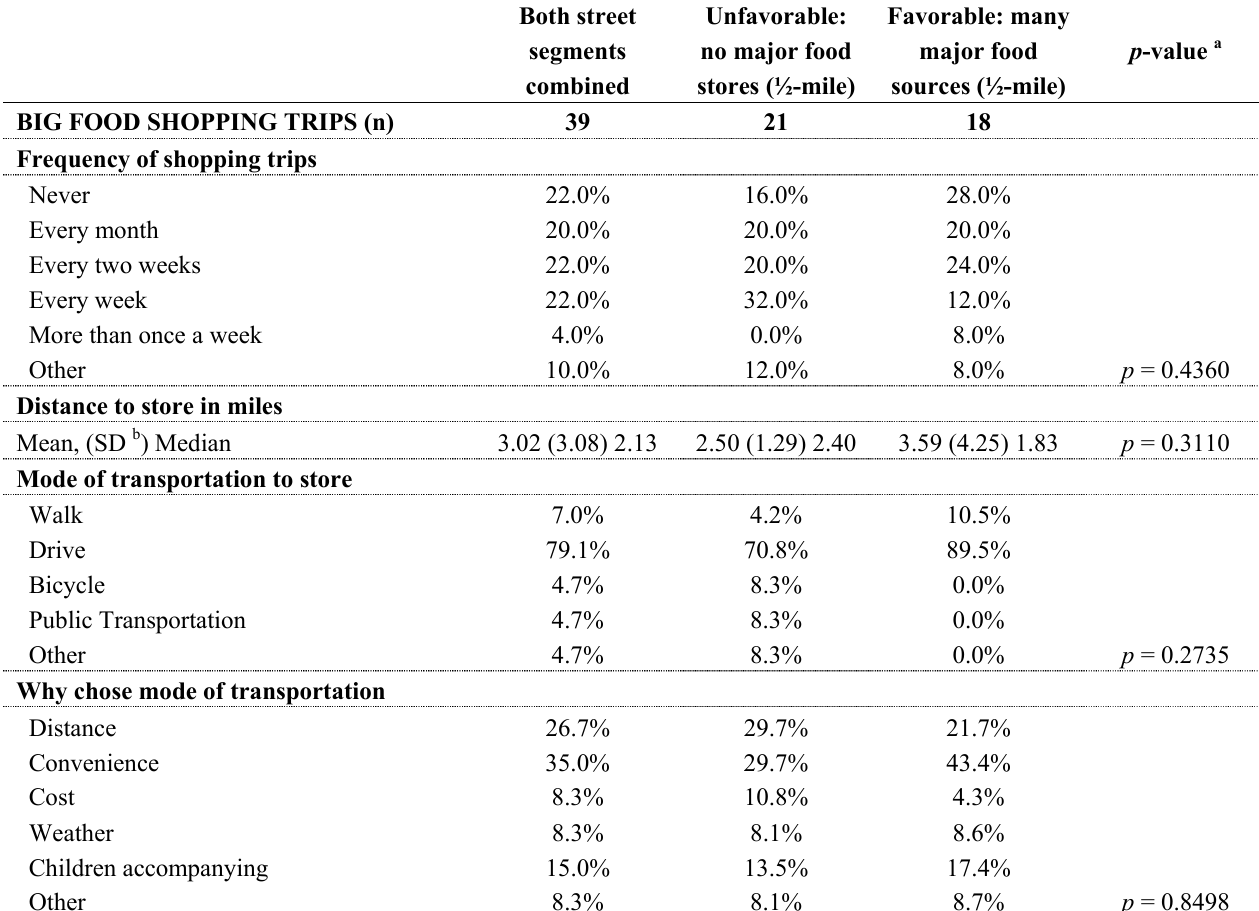
Table 2. Food shopping patterns for big and small food shopping trips by block of residence (n = 50). Both